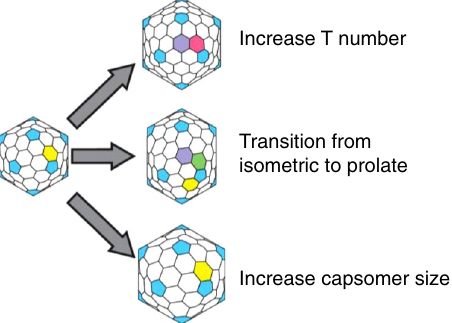
Fig. 9 Mechanisms for increasing capsid capacity. P74-26 adopts a novel mechanism for enhancing capsid capacity by increasing the size of capsomers, while retaining T = 7